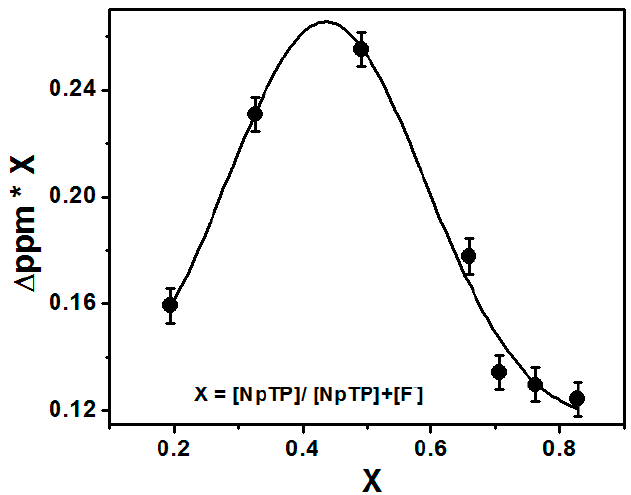
Figure 7. Job’s plot through NMR titration of NpTP upon the addition of TBAF in CD 3 CN.